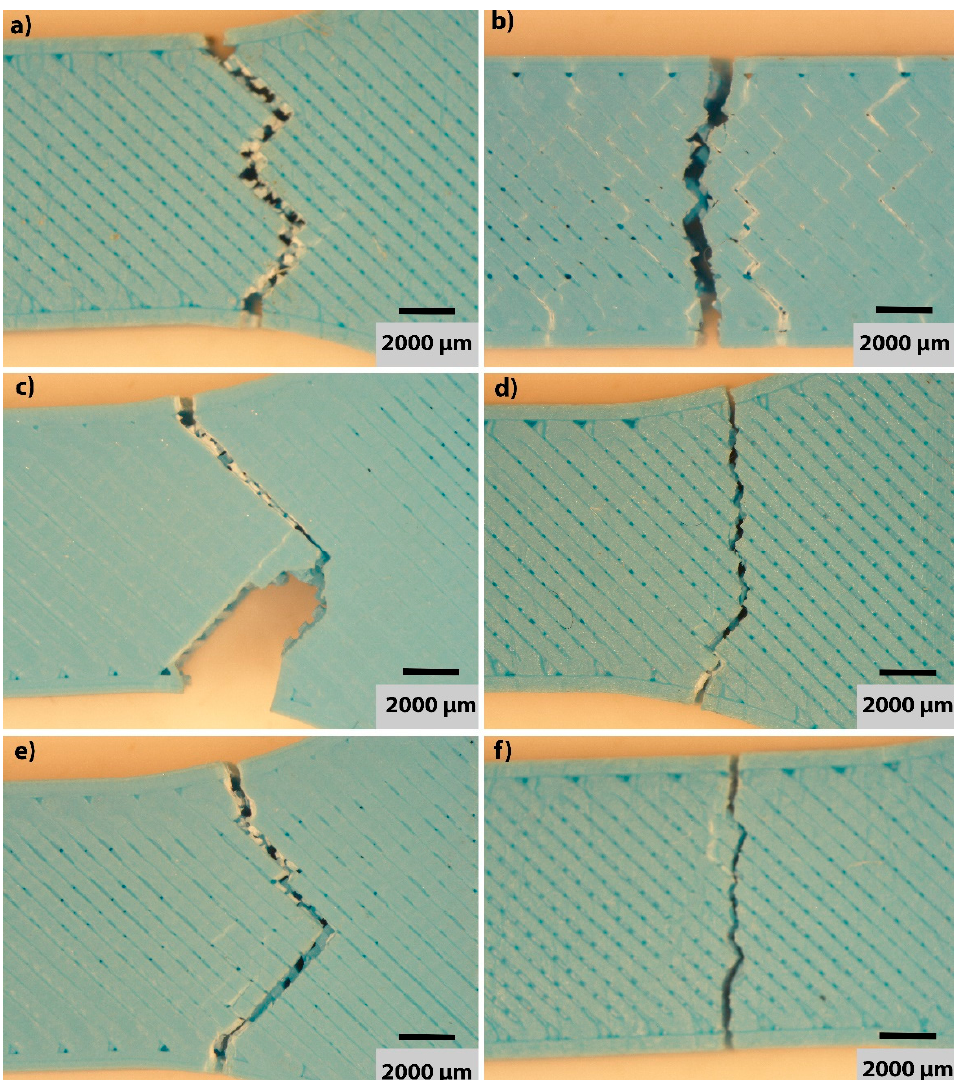
Figure 4. Macrostructural aspect at stereomicroscope of polylactic acid material, in longitudinal cross section, with different 3D printing parameters: ( a ) 60% interior fill percentage and 45 ° thread deposition;( b ) 60% interior fill percentage and 60 ° thread deposition;( c ) 80% interior fill percentage and 45 ° thread deposition;( d ) 80% interior fill percentage and 60 ° thread deposition; ( e ) 100% interior fill percentage and 45 ° thread deposition; ( f ) 100% interior fill percentage and 60 ° thread deposition.